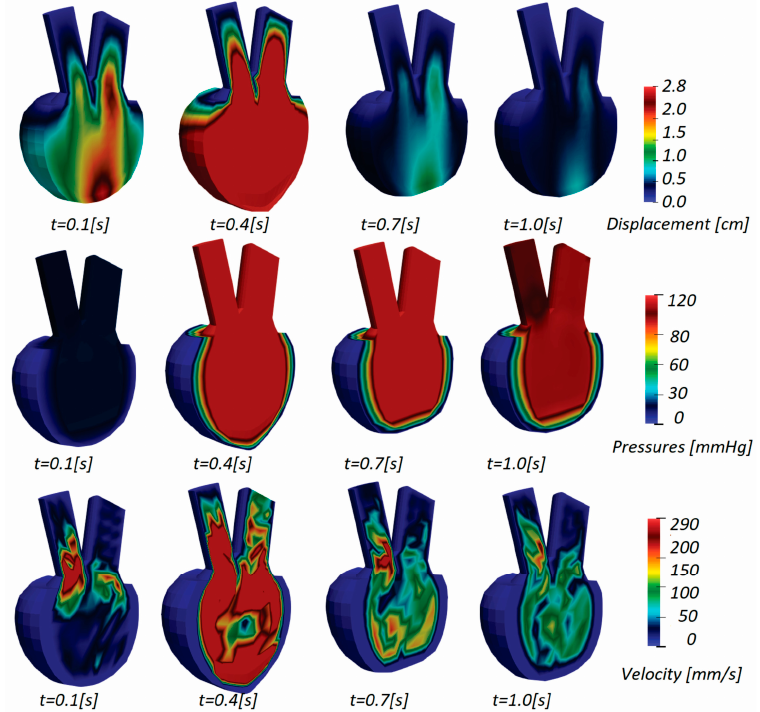
Figure 10. Displacement, pressures, and velocity fields for patient 3.